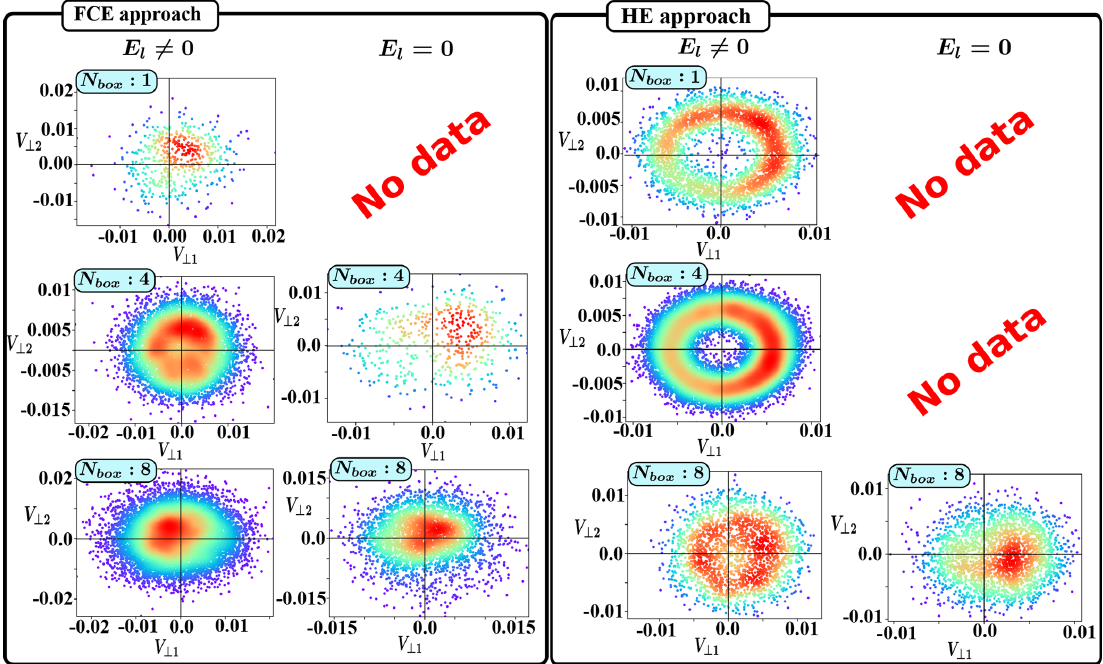
Figure 10. Local perpendicular ion velocity space ( v ⊥ 1 , v ⊥ 2 ) of all back-streaming ions computed at the end time of the simulations (i.e., after 3 τ ci for all simulations) for boxes N Box = 1 , 4 and 8 in the FCE approach when the (cid:101) E l is included (left panel); the case (cid:101) E l = 0 is not plotted since the percentage BI % is very weak (see Fig. 8). The right panel shows similar results for the same boxes in the HE configuration (corresponding to (cid:101) T = 4848) in both cases where (cid:101) E l is included and artificially excluded; statistical results where BI % is too weak are not shown. Red and blue hold for maximum and minimum density value in the velocity